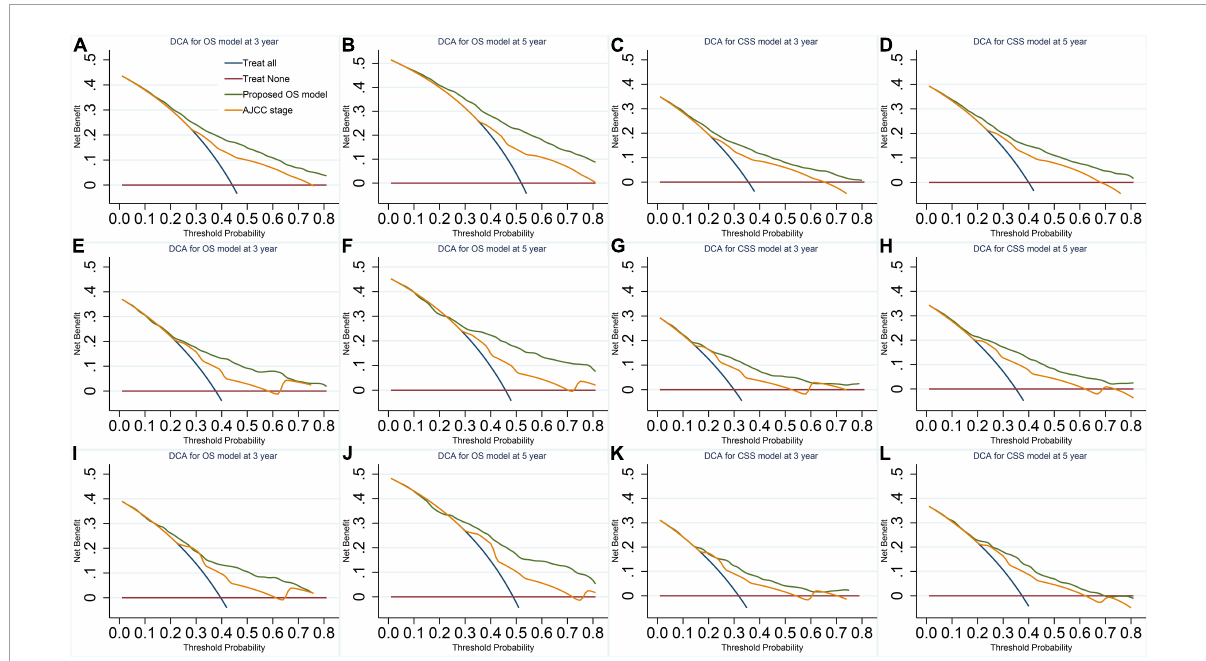
FIGURE2 Decision curves of the final overall survival (OS) and cancer-specific survival (CSS) models. (A,B) OS model in the imputed training cohort. (C,D) CSS model in the imputed training cohort. (E,F) OS model in the complete cases of the validation cohort. (G,H) CSS model in the complete cases of the validation cohort. (I,J) OS model in the imputed validation cohort. (K,L) CSS model in the imputed validation cohort. The plots of decision curves illustrate that our models have larger net benefits than the American Joint Committee on Cancer stage in predicting the 3- and 5-year survival of vaginal cancer patients, showing better clinical